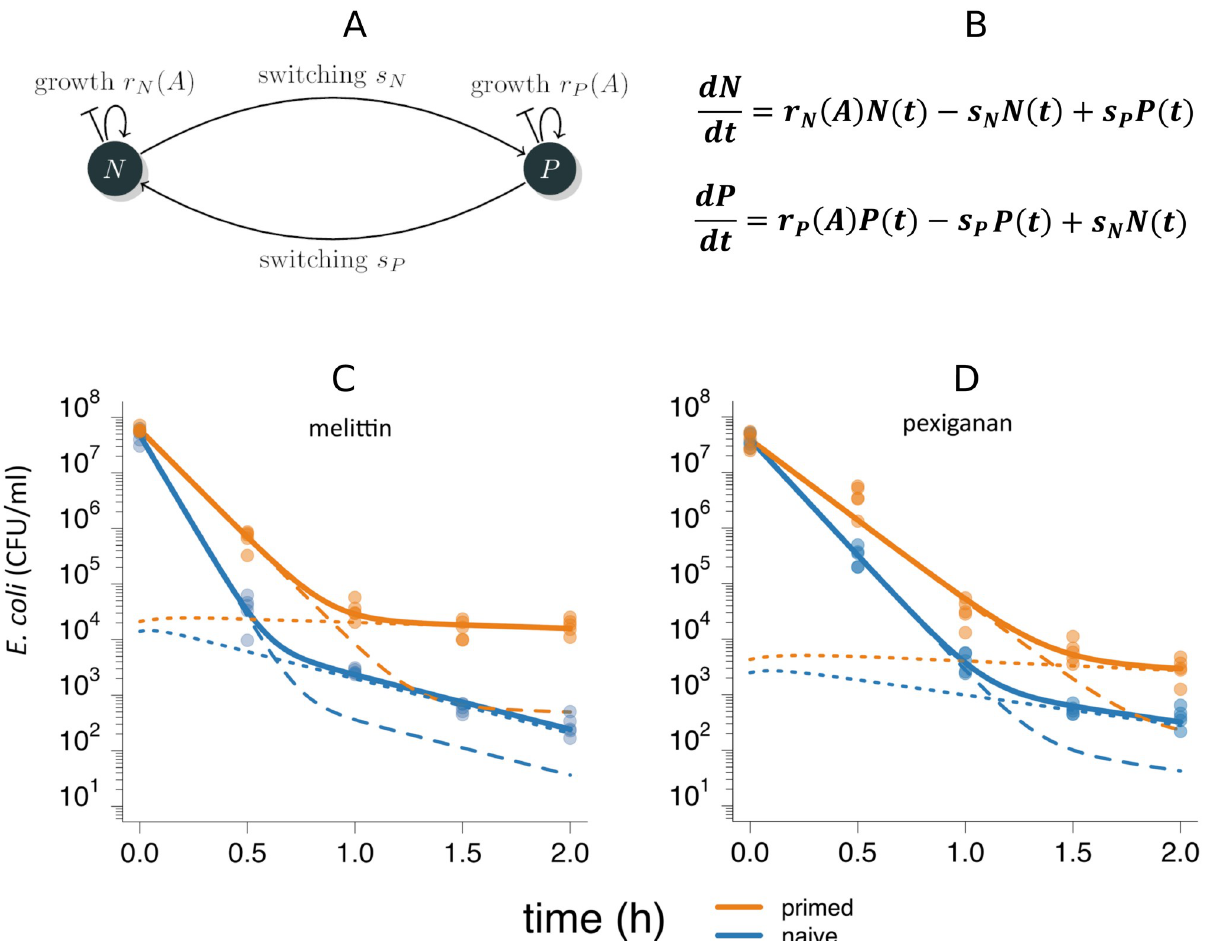
Fig 2. The two-state model describes time-kill data. (A) The two-state model (adapted from 29 ) consists of two subpopulations, normal cells ( N ) and persister cells ( P ) and is parameterized with the growth rates r N (A) and r P (A), which are dependent on the concentration of AMPs (A) in the system, and the switching rates s , and s . Each subpopulation is described with an ordinary differential equation (B), which describes the change of the N P respective subpopulation over time. For each antimicrobial, melittin (C) and pexiganan (D), we fitted the model to the data of naive (blue) and primed (orange) bacterial populations (see also Fig 1) individually. The continuous lines represent the total bacterial population B(t) , with B(t) = N(t) + P(t) , and the dashed and dotted lines represent the subpopulations N(t) and P(t) , respectively. Bacteria primed with melittin have an increased net growth rate r and decreased s compared to the naive populations. In the case of pexiganan, the parameter r N P naive populations. For an overview of the fitted parameters, see S5